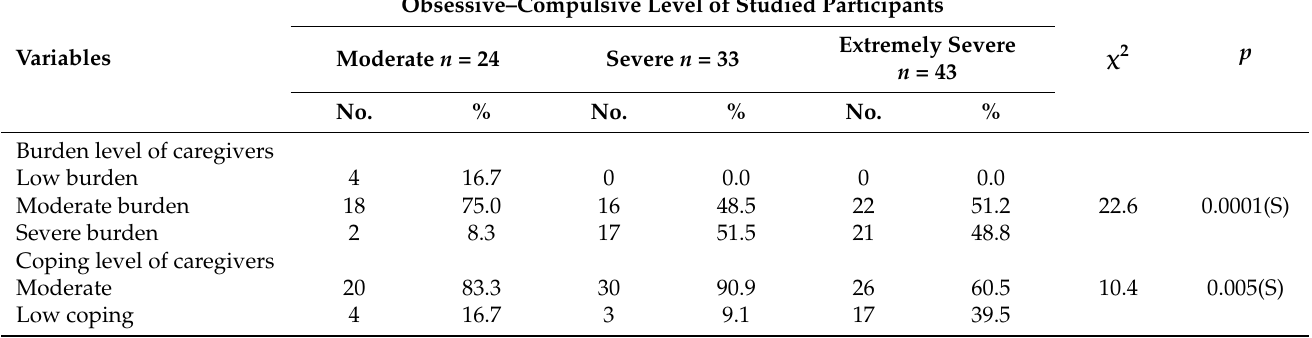
Table 2. The relation between the OCD symptom severity of participants with OCD, caregivers’ burden and coping